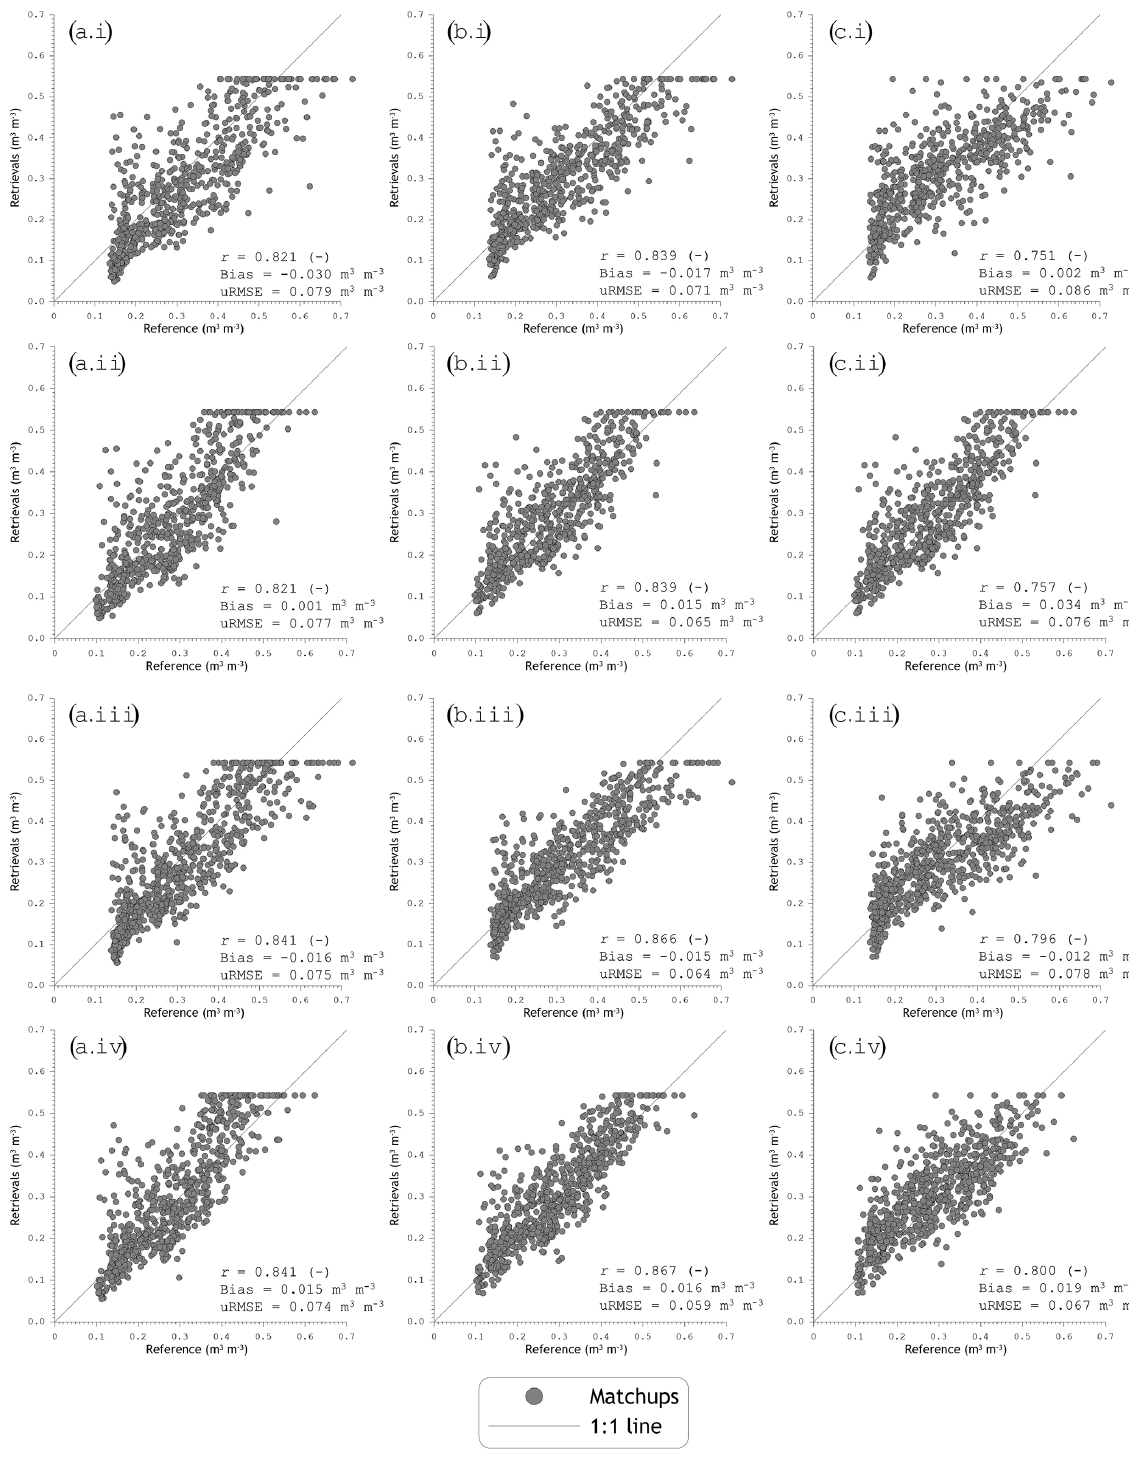
Figure 12. Scatter plots of SMAP soil moisture retrievals for reference pixel 4371 versus in situ references available from April 2015 till December 2018. Panels (a) , (b) , and (c) indicate SMAP estimates derived using SCA-H, SCA-V, and DCA, respectively; (i) and (ii) are for SMAP’s morning overpass, and (iii) and (iv) are for the afternoon overpasses; (i) and (iii) include references based on the unbiased seven-station mean soil moisture, and (ii) and (iv) use the all-station mean as a reference.